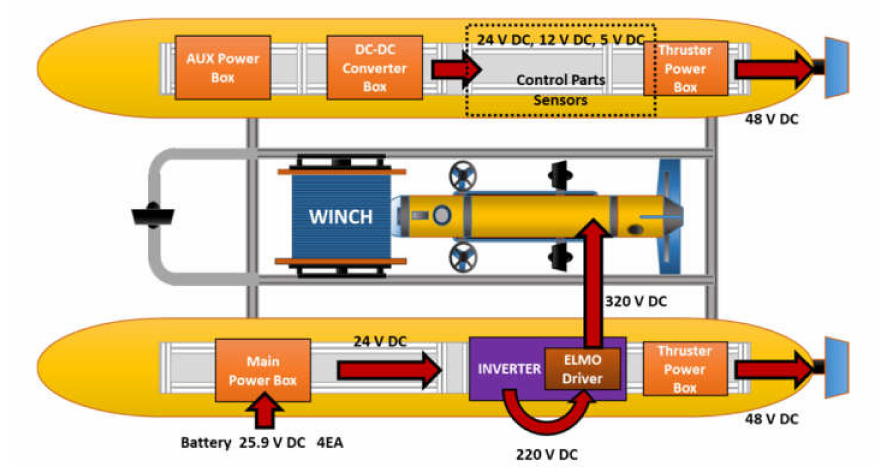
Figure 9. Diagram of USV power system.